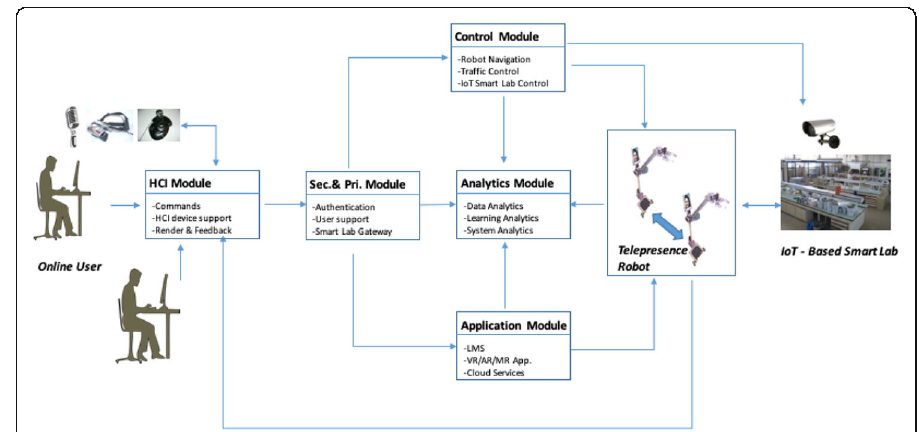
Fig. 3 The data flow diagram of the TRESL